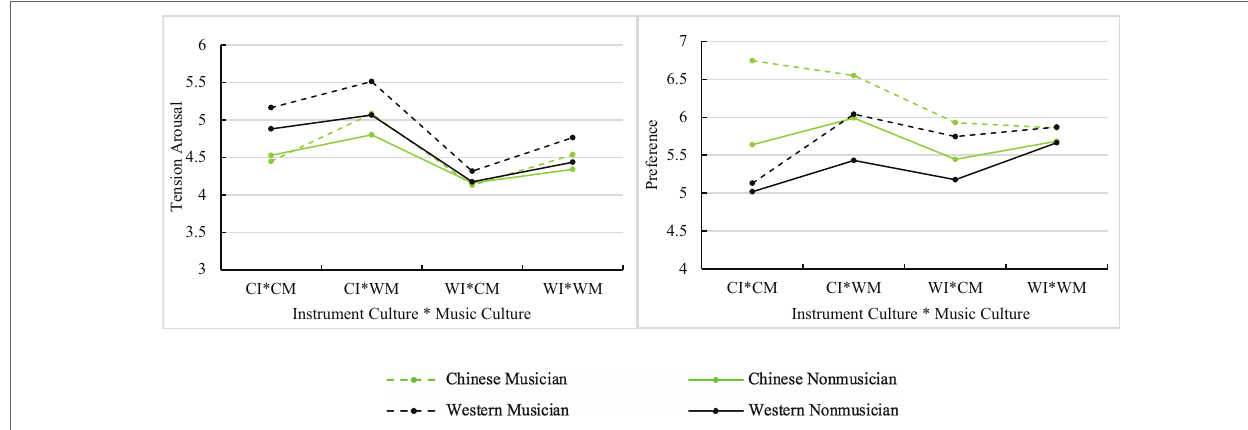
FIGURE 6 | The results of the three-way interaction effects between listener group, instrument culture, and musical culture on tension arousal and preference. CI, Chinese instruments; CM, Chinese music; WI, Western instruments; and WM, Western music.